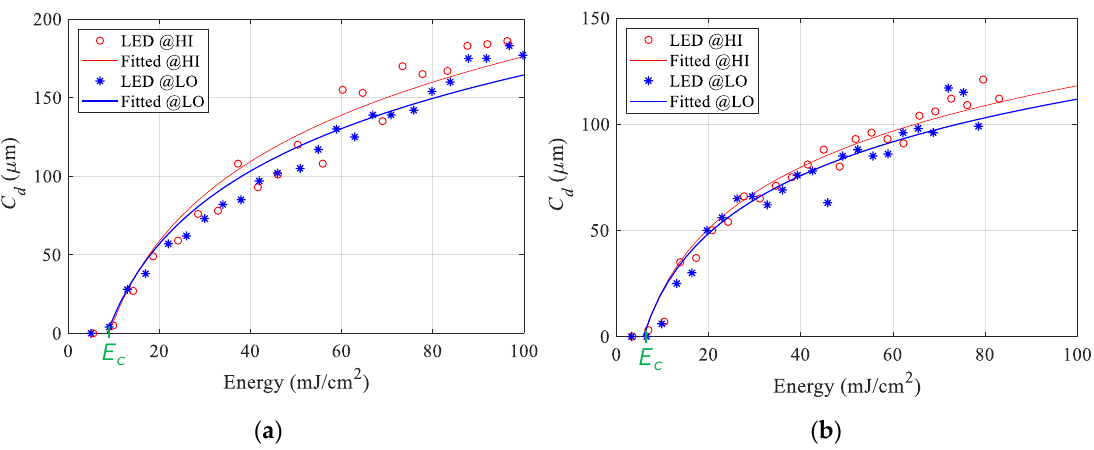
Figure 9. Working Curve from ( a ) continuous exposure pattern ( b ) discrete sequential pattern.